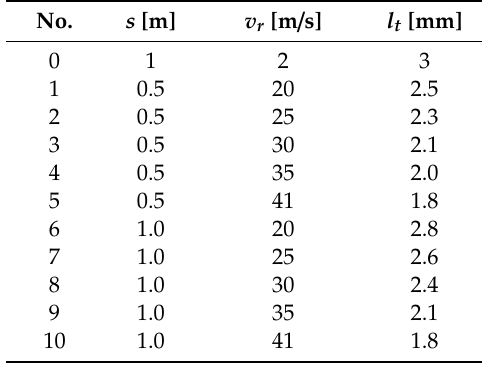
Table 9. The dependence of the R a , on the feed rate of PO and on the thickness of the metal band. No.